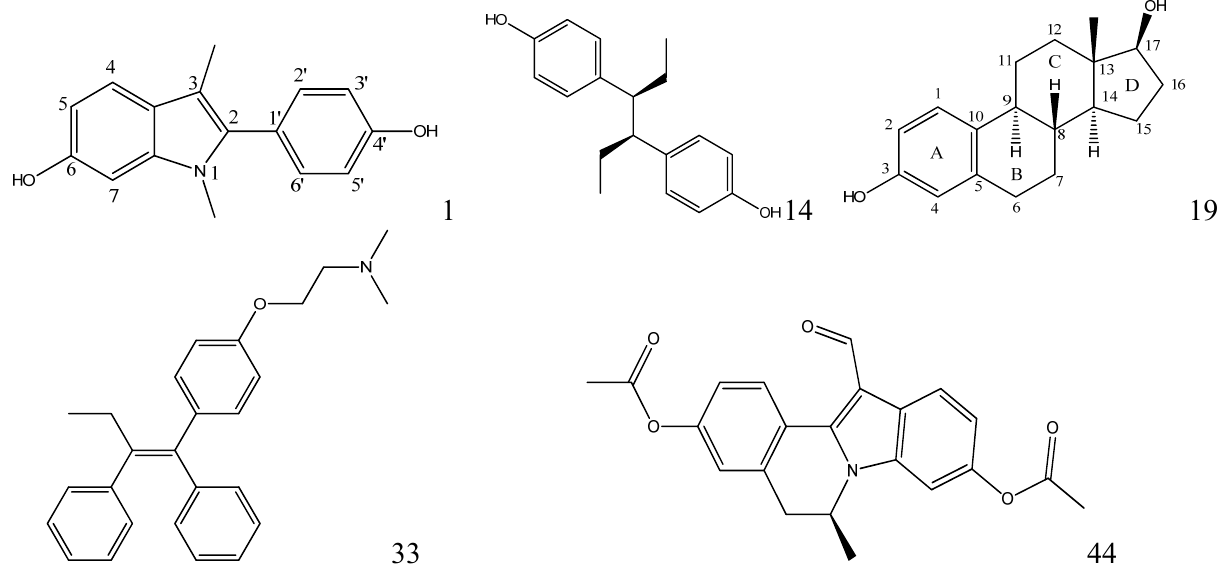
Figure 4. The chemical structures of various natural or synthetic estrogens used in this study.